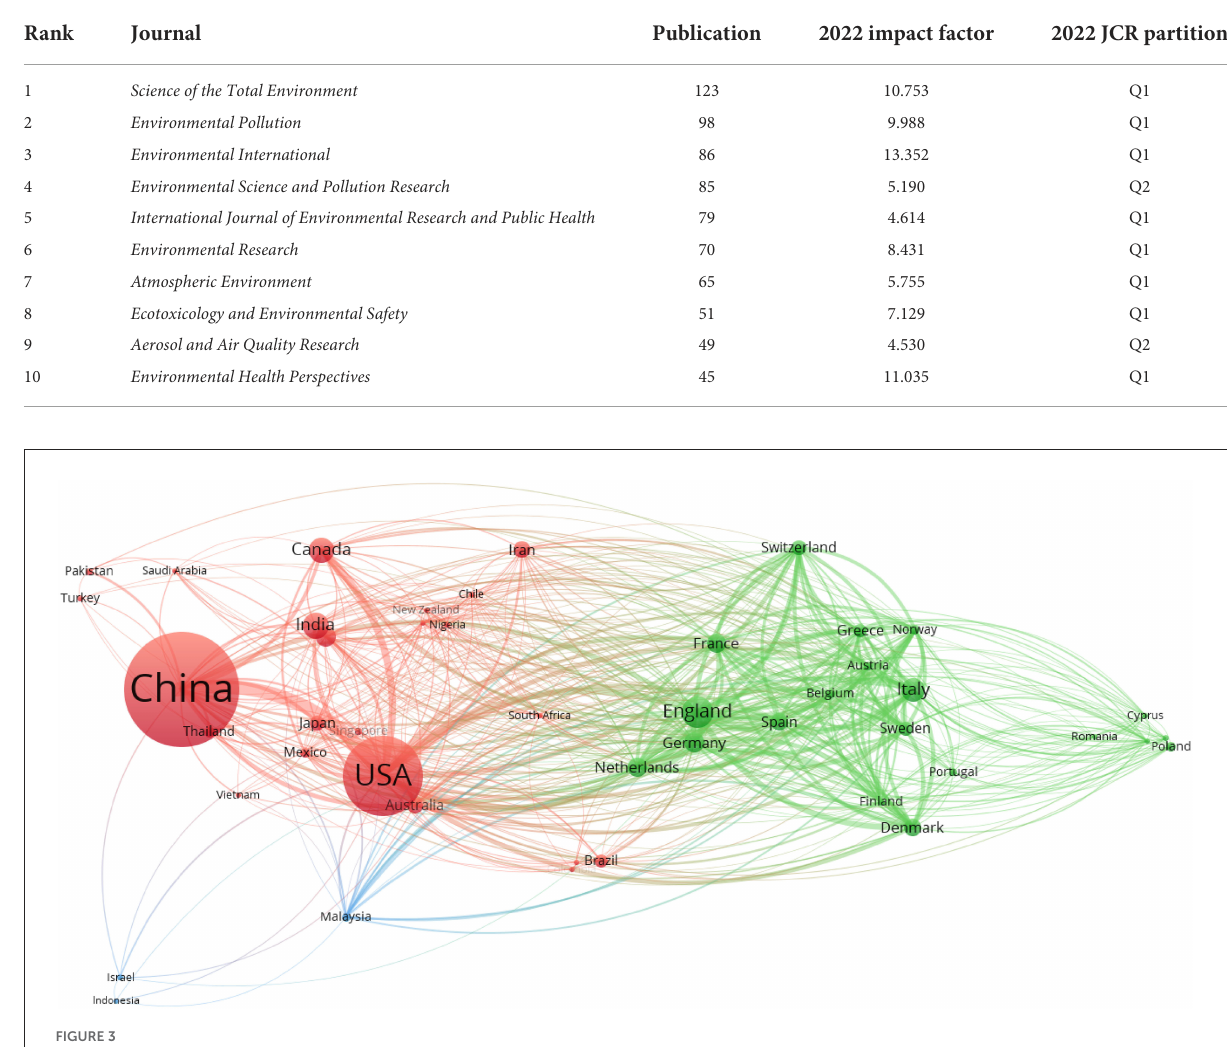
FIGURE3 Network map of